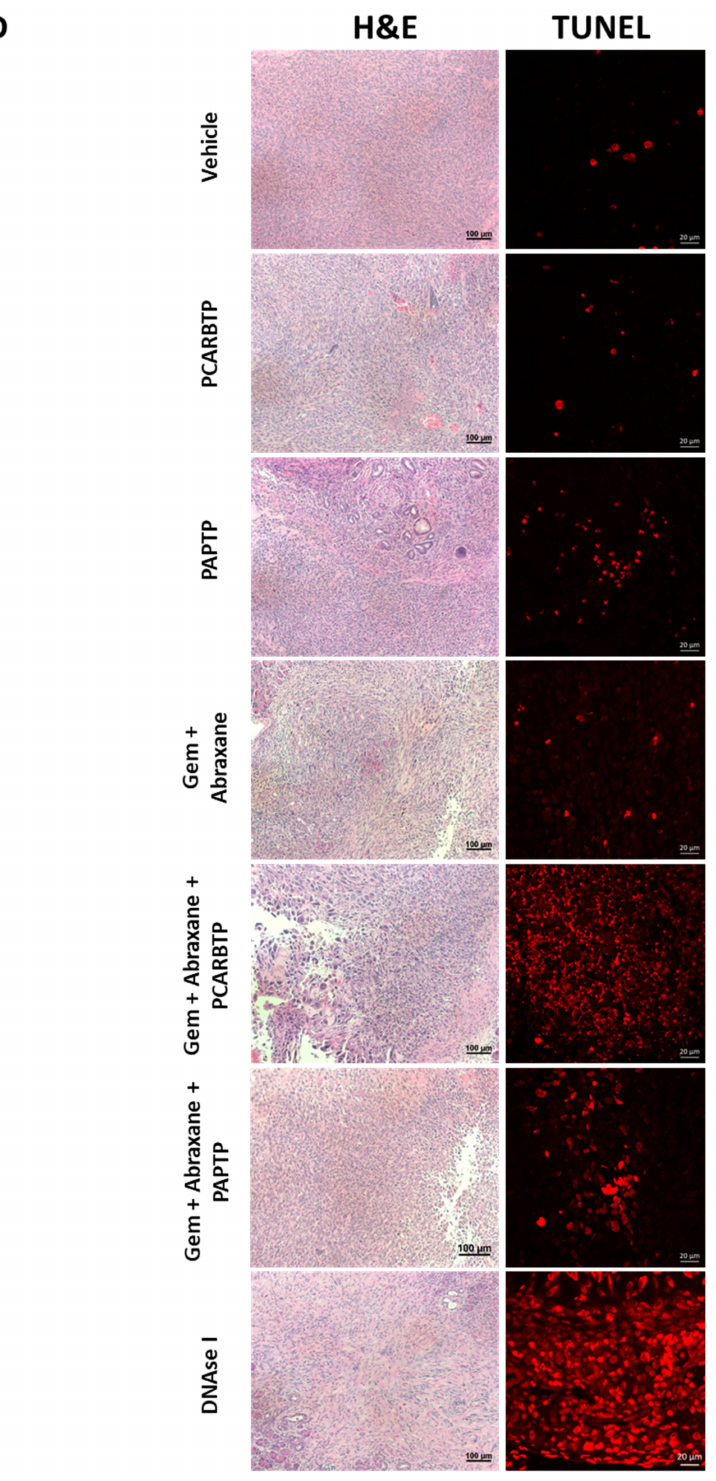
Figure 5. PCARBTP or PAPTP combined with Gemcitabine and Abraxane drastically reduced pancreatic tumor size and weight an orthotopic mouse model. ( A , B ) PCARBTP and PAPTP combined with Gemcitabine and Abraxane reduced up to 95% the pancreas tumor volume ( A ) and weight ( B ) compared to the control group. n = 8. ( C ) Representative pictures of the mouse orthotopically injected tumors. ( D ) H&E staining and TUNEL assay of indicated organs. DNase treatment was used as a positive control. Treatment groups shown in in the figure resulted in greater tumor cell death compared to the vehicle control. Scale bars for H&E = 100 µ m, scale bars for TUNEL = 20 µ